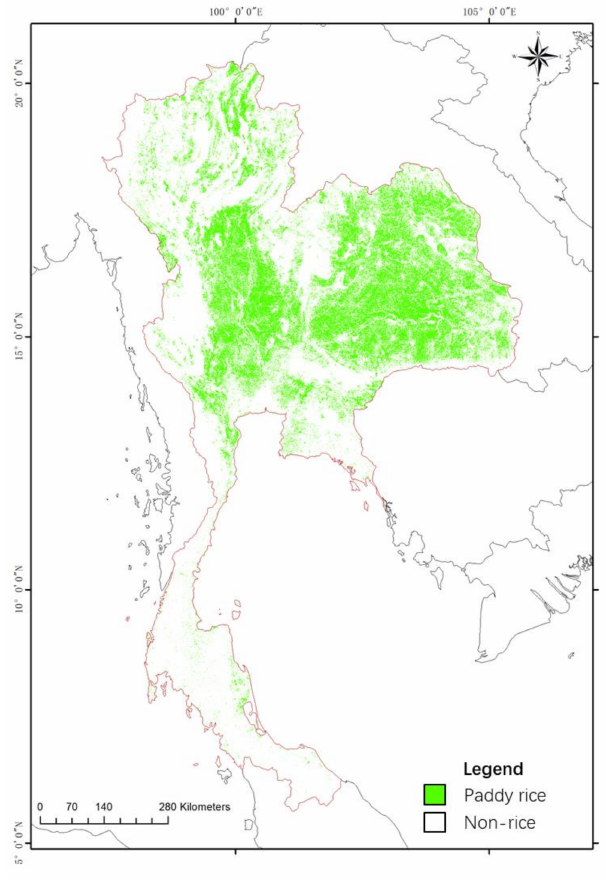
Figure 16. Paddy rice mapping result of